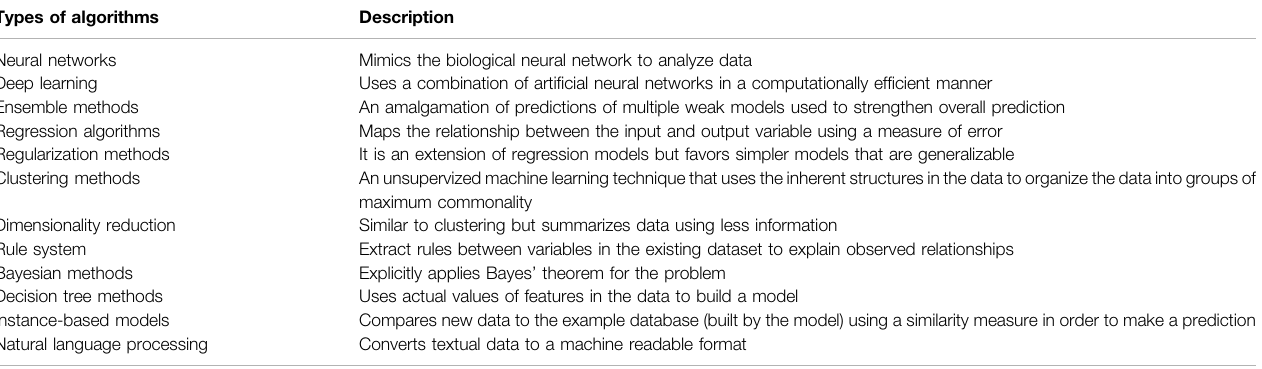
TABLE 1 | Categorization and brief description of ML models.